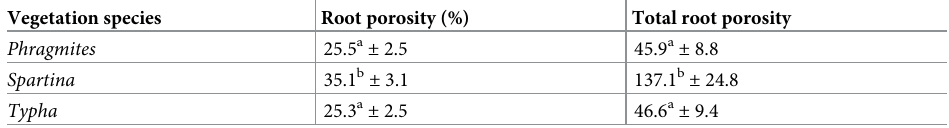
Table 1. Root porosity differed among vegetation